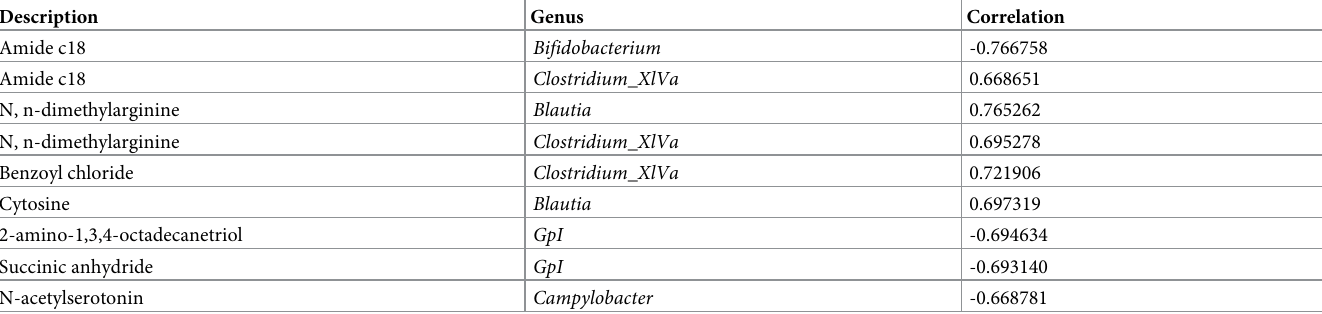
Table 1. Correlation of the metabolite levels with the abundance of gut microbiota in the control and model